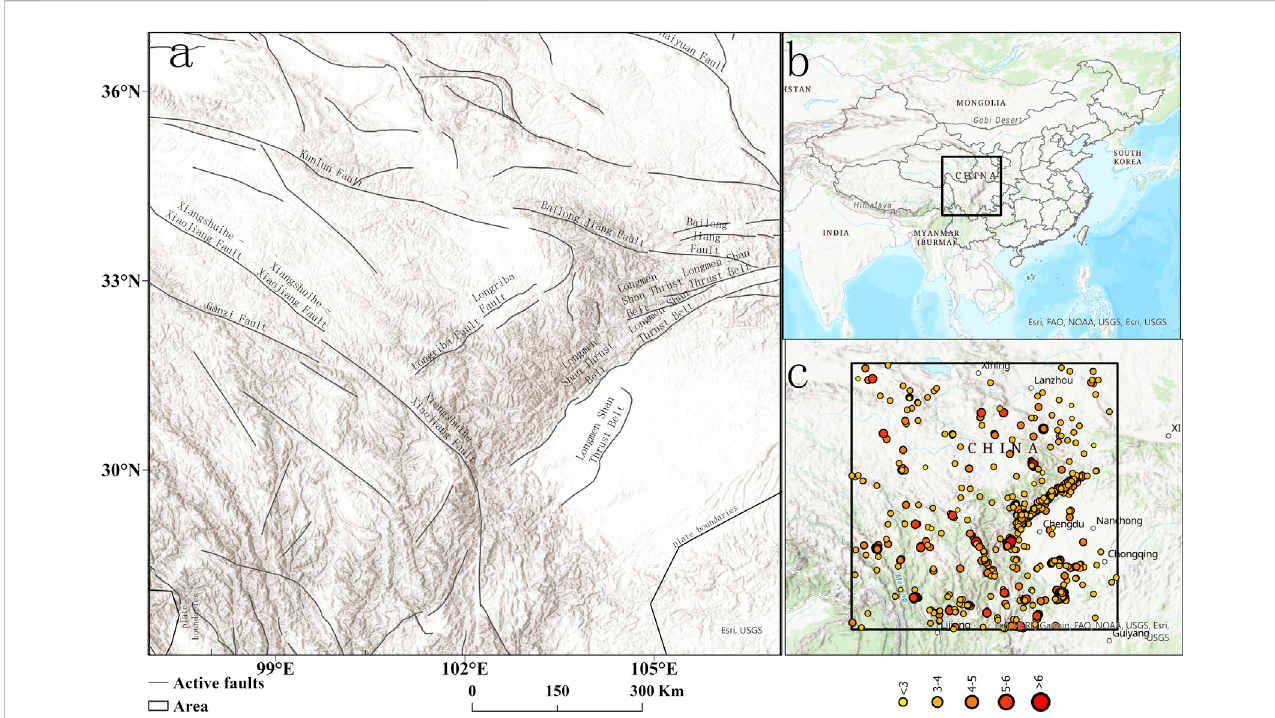
FIGURE 1 (A) isthelocationofthestudyareaandthedistributionofactivefaults, (B) illustratesthatthestudyareaisatthejunctionofYunnan,SichuanandGansuin China, and (C) is the magnitude 3 – 8 earthquakes that have occurred in the study area in